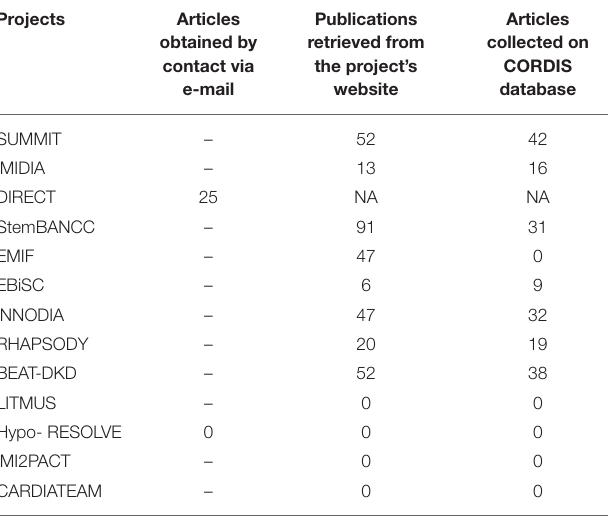
TABLE 1 | Summary of sources and publications included in this